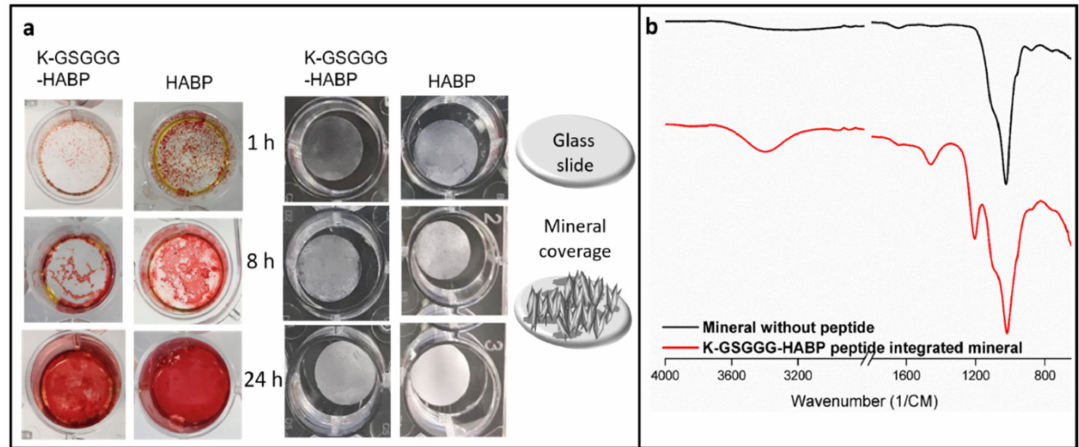
Figure 4. ( a ) Mineral layer obtained on the surface of the 24-well plate at different time points were stained with Alizarin red (Left), the minerals produced on the slides. The increasing mineral coverage on the glass slides over different time points (right). ( b ) FTIR results of the minerals obtained after overnight mineralization reaction with and without